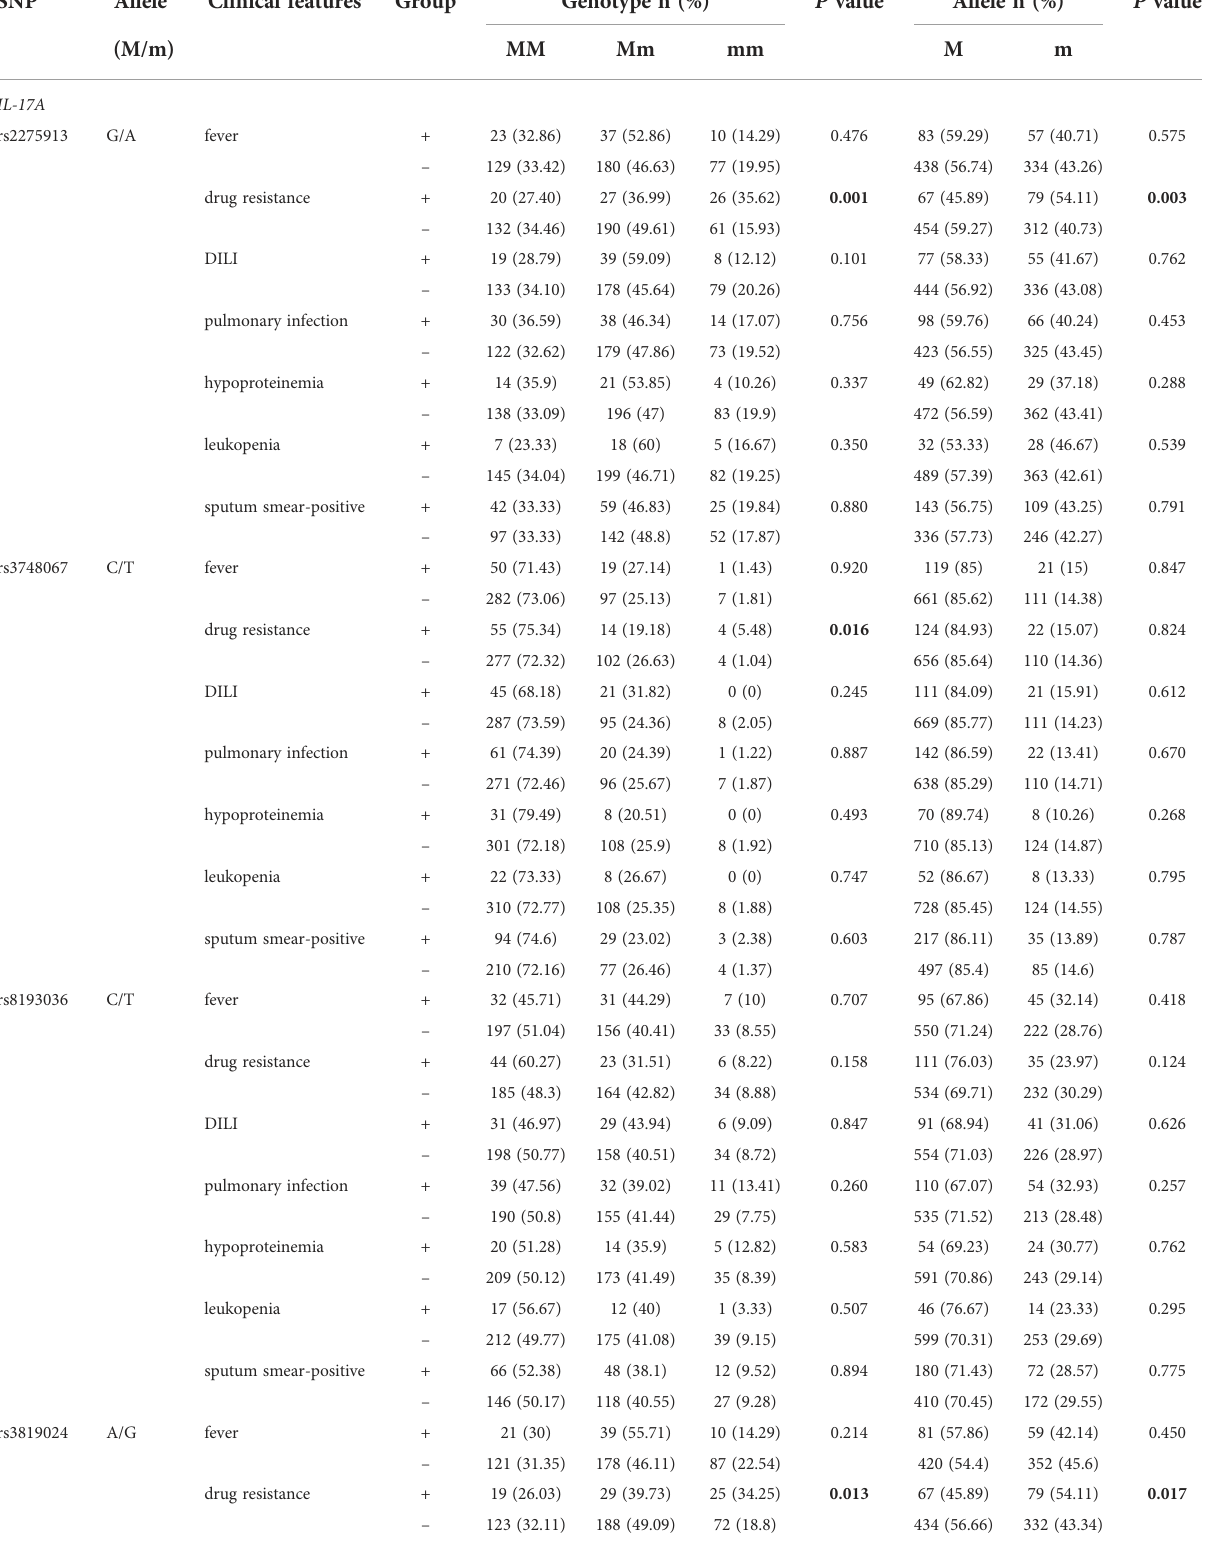
TABLE 2 Association between Th17 pathway genes polymorphisms and the clinical manifestations of PTB patients. SNP Allele